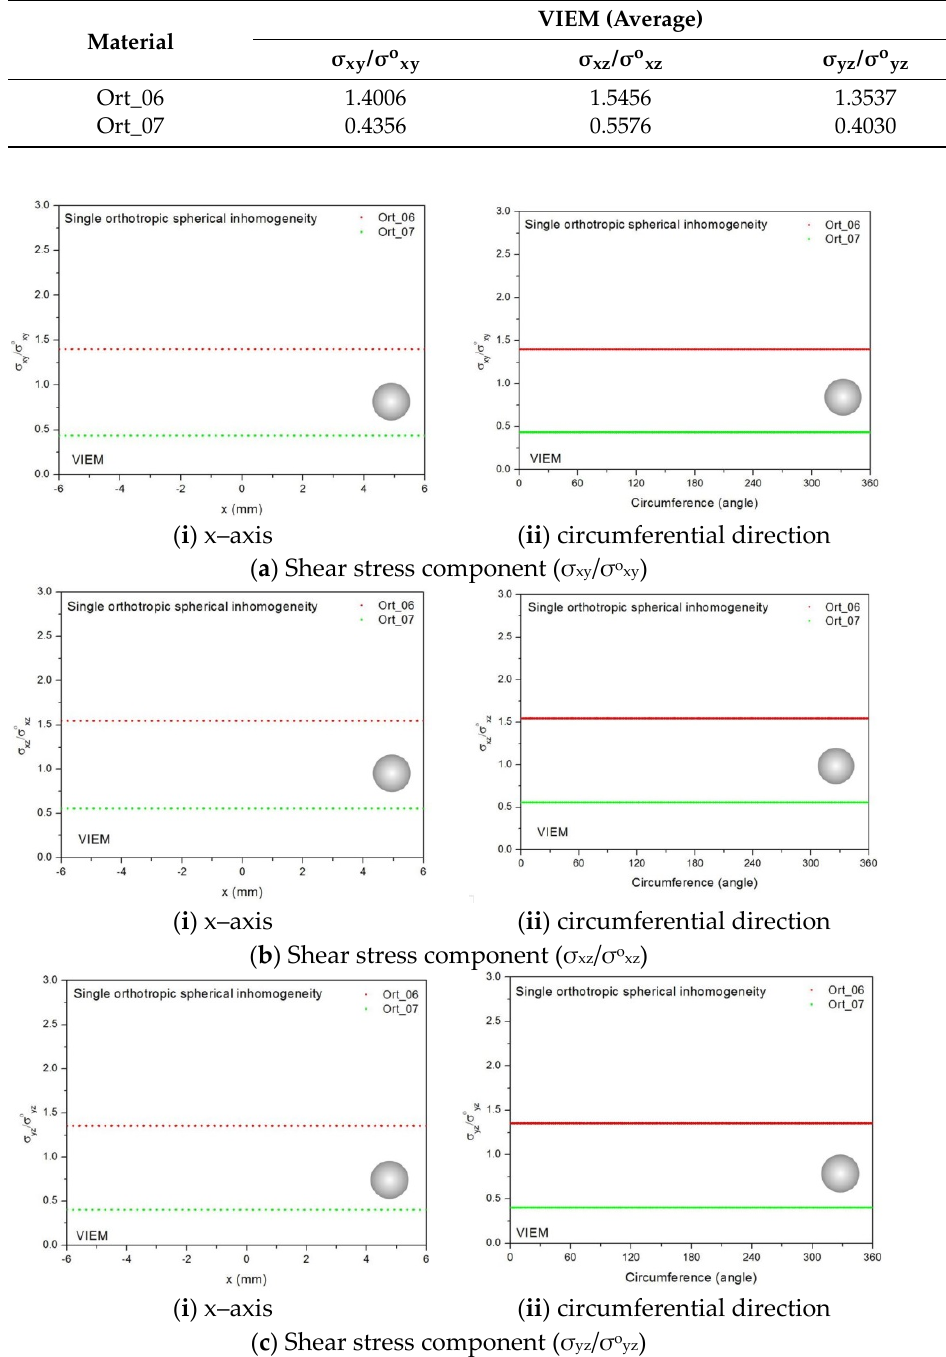
Figure 23. VIEM results for the normalized shear stress components ( a ) σ xy / σ oxy , ( b ) σ xz / σ oxz and ( c ) σ yz / σ oyz along ( i ) the x–axis inside and ( ii ) the circumferential direction of the orthotropic spherical inclusions (Ort_06 and Ort_07) with a radius of 6 mm under remote shear loading ( σ oxy , σ oxz and σ oyz ). Table 19. Normalized shear stress components ( σ xy / σ oxy , σ xz / σ oxz and σ yz / σ oyz ) within the orthotropic spherical inclusion due to remote shear loading ( σ oxy , σ oxz and σ oyz ).